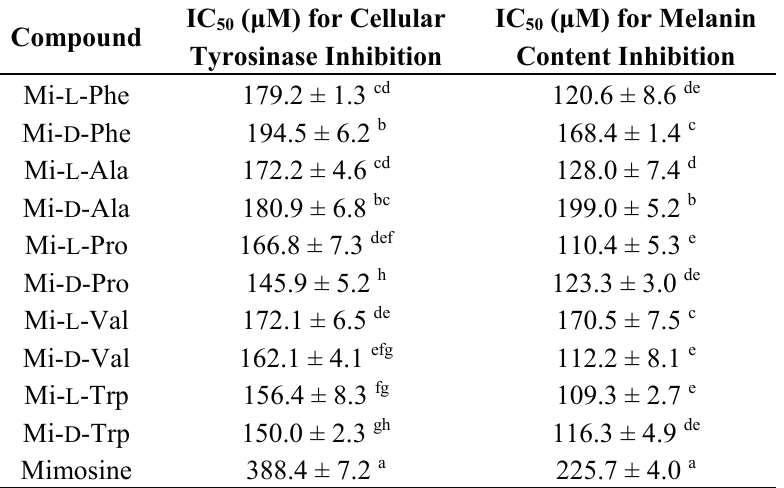
Different letters in the same column indicate the existence of significant difference statistically. Values represented as mean ±